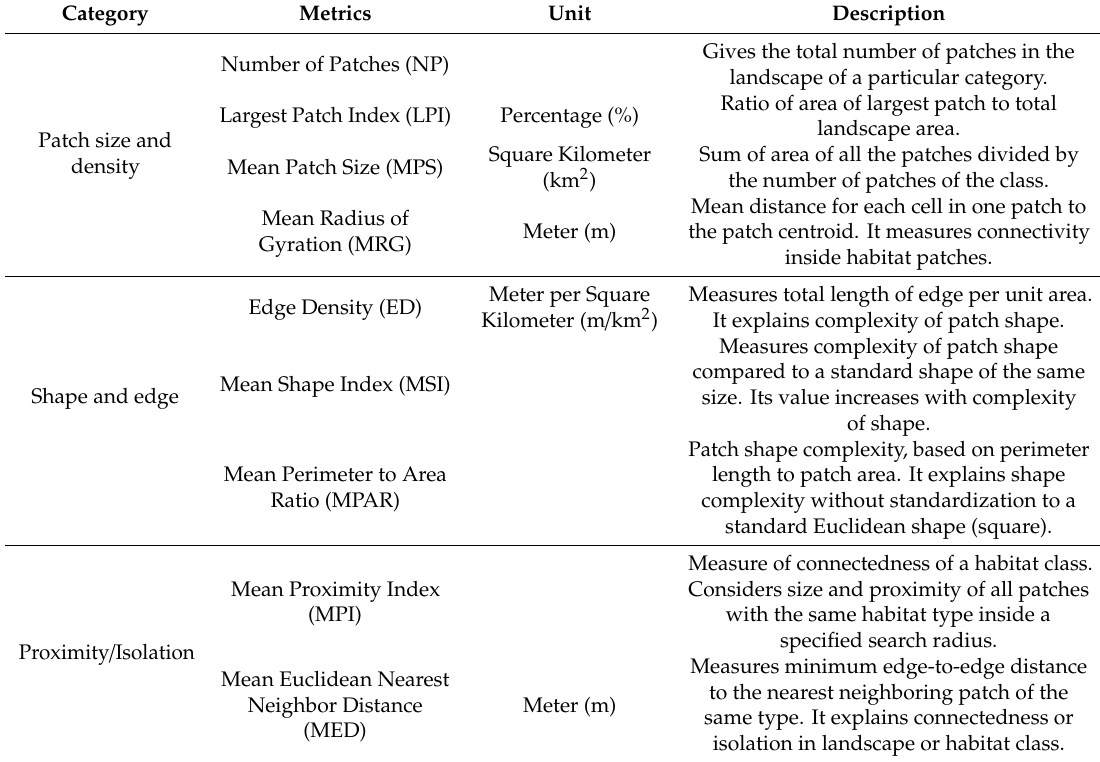
Table 3. Land cover class level description of landscape metrics used in this